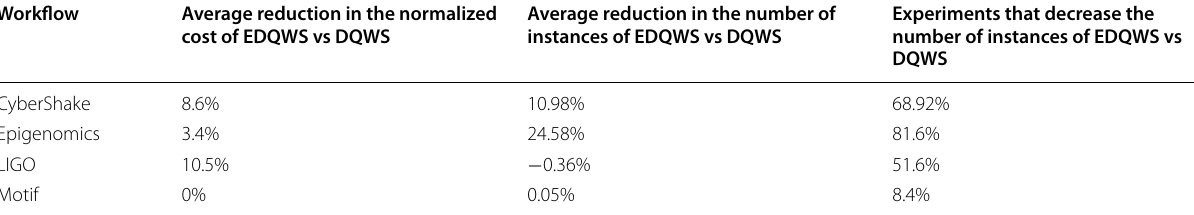
Table 3 Comparison of EDQWS and DQWS in the number of instances and normalized cost